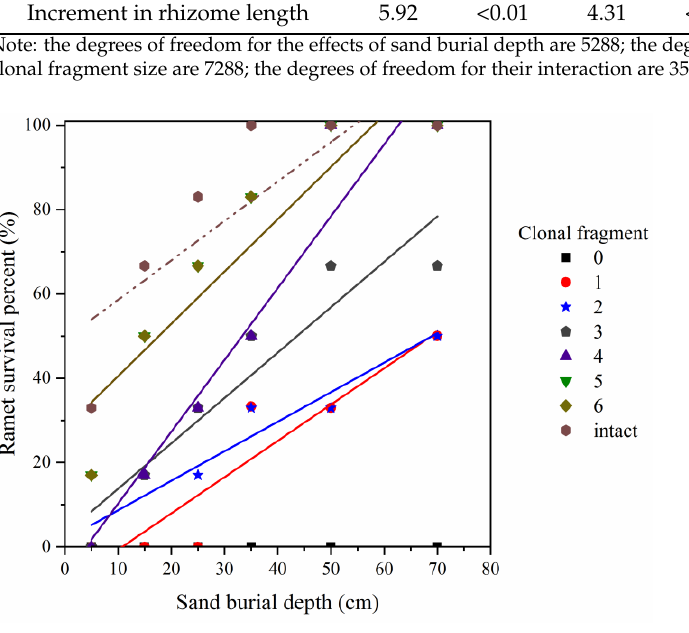
Figure 1. Effects of sand burial depth and clonal fragment size on ramet survival percentage. The variable y is ramet survival percentage, and the variable x is sand burial depth: y 0 = 0, R 2 = 1, p = 0.003; y 1 = 0.86x − 9.30, R 2 = 0.86, p = 0.008; y 2 = 0.70x + 1.65, R 2 = 0.92, p = 0.002; y 3 = 1.08x + 2.98, R 2 = 0.89, p = 0.005; y 4 = 1.70x − 6.82, R 2 = 0.93, p = 0.002; y 5 = 1.24x + 28.06, R 2 = 0.84, p = 0.009; y 6 = 1.24x + 28.06, R 2 = 0.84, p = 0.009; y intact = 0.94x + 49.25, R 2 = 0.69, p = 0.041.